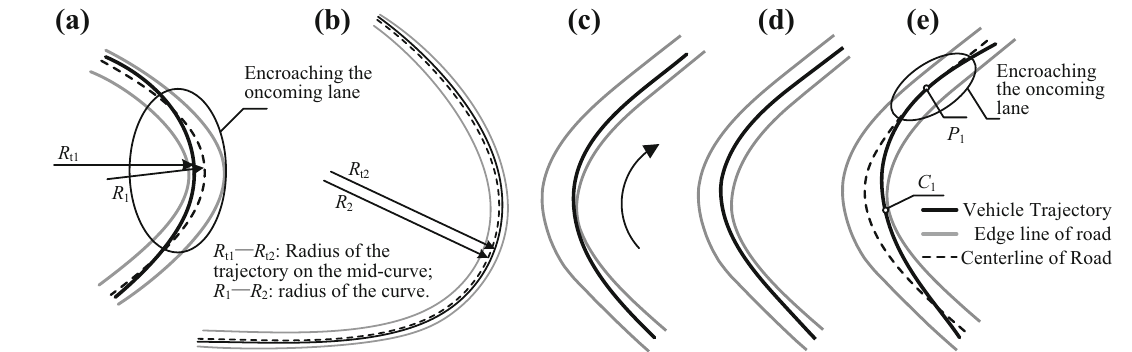
Fig. 9 Trajectory at ( a ) sharp left bend and ( b ) large-radius left bend; ( c – e ) typical trajectories at small-radius right bend